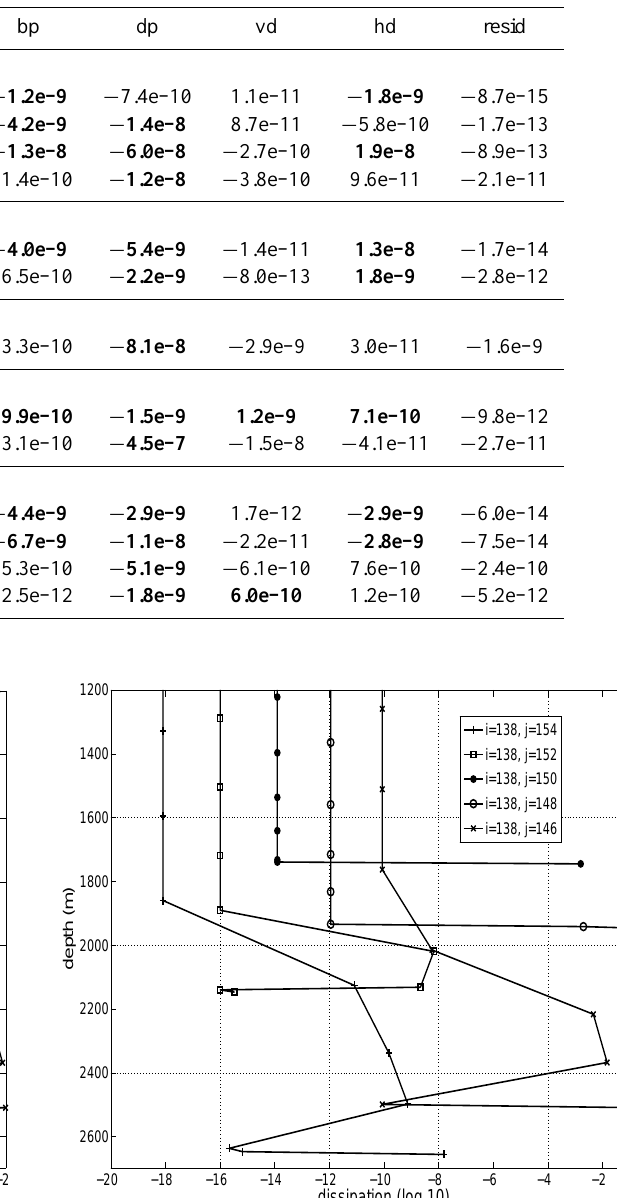
Table 2. Same as Table 1 but for q 2 ‘ .